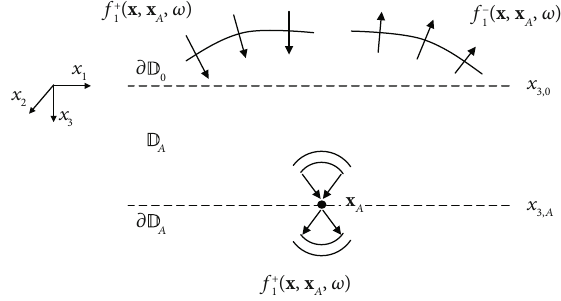
Figure 5: Con fi guration for the derivation of the single-sided Kirchho ff -Helmholtz integrals for backward